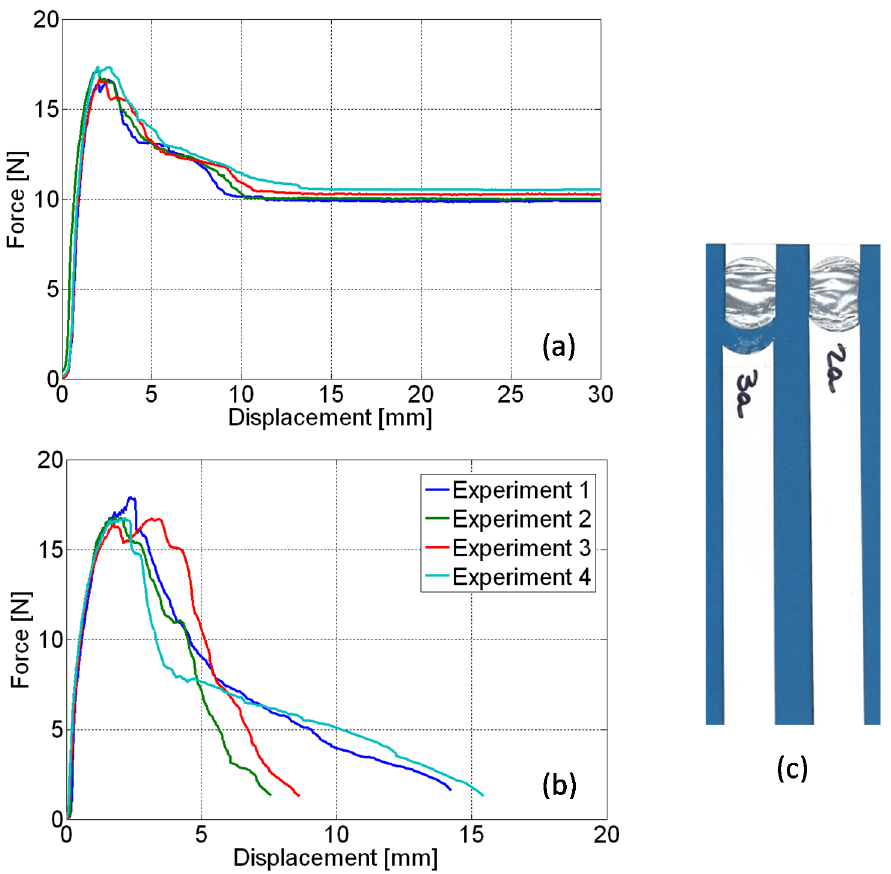
Figure 4. ( a , b ) Overall load-displacement curves concerning specimens cut from different material batches and subjected to uniaxial tension test; ( c ) final configuration of specimens after their removal from the testing